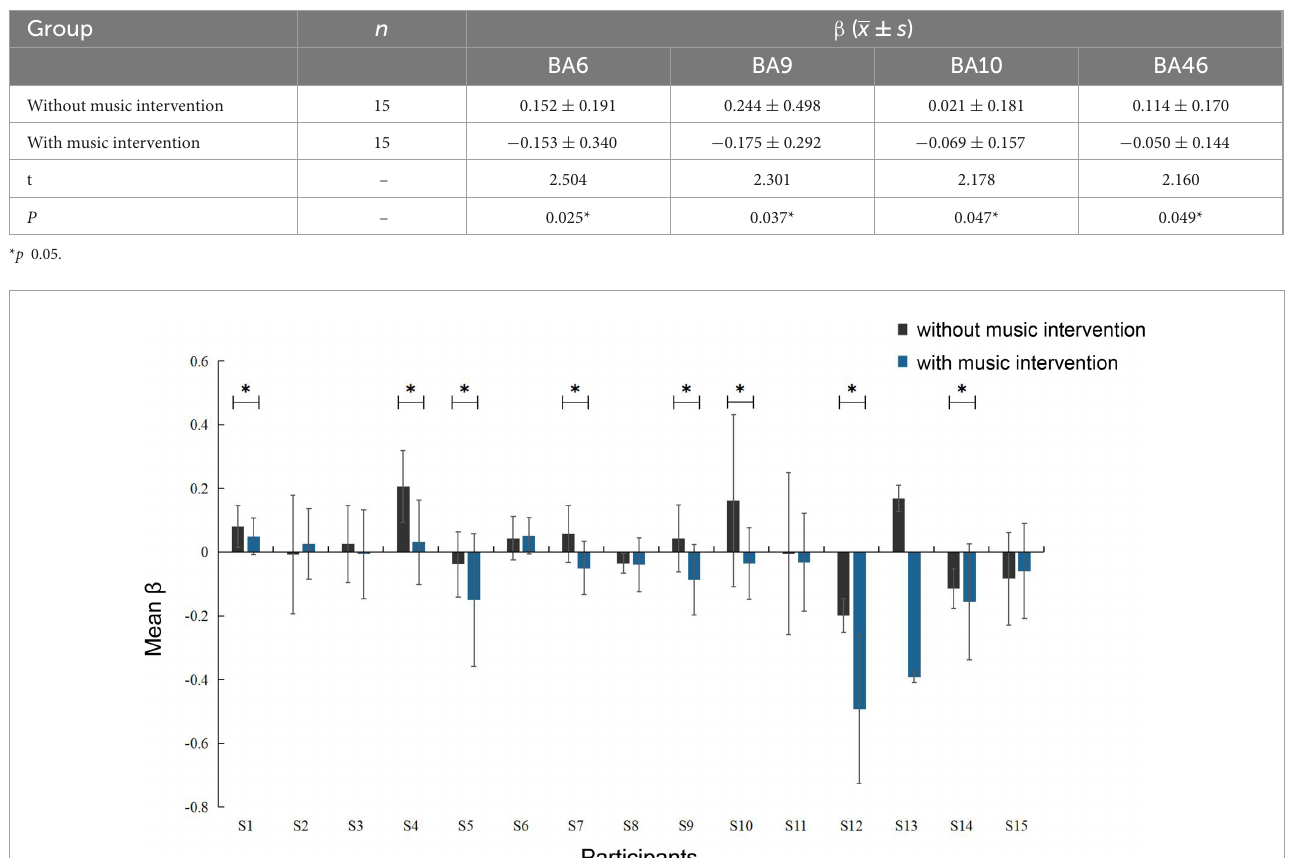
TABLE 3 Comparison of activation intensity between the two groups.